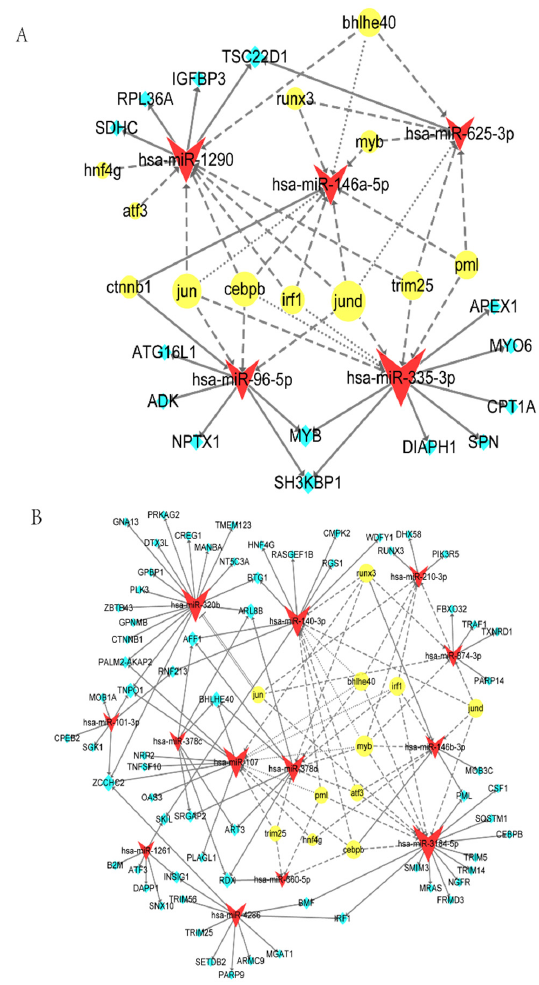
Figure 4. TF-miRNA-mRNA network. ( A ) Network analysis of 5 uniquely upregulated DE-miRNAs (red), 14 predicted targets (blue), and 12 predicted TFs (yellow) by Cytoscape. The size of the shape represents the degree of the nodes. Solid arrow, miRNA targets mRNA or TF activates miRNA; line dotted arrow, TF regulates miRNA; dotted arrow, TF regulates (feedback) miRNA. ( B ) Network analysis of 13 uniquely downregulated DE-miRNAs (red), 67 predicted targets (blue), and 11 predicted TFs (yellow) by Cytoscape. The size of the shape represents the degree of the nodes. Solid arrow, miRNA targets mRNA or TF activates miRNA; line dotted arrow, TF regulates miRNA; dotted arrow, TF regulates (feedback) miRNA; double solid, TF represses miRNA.